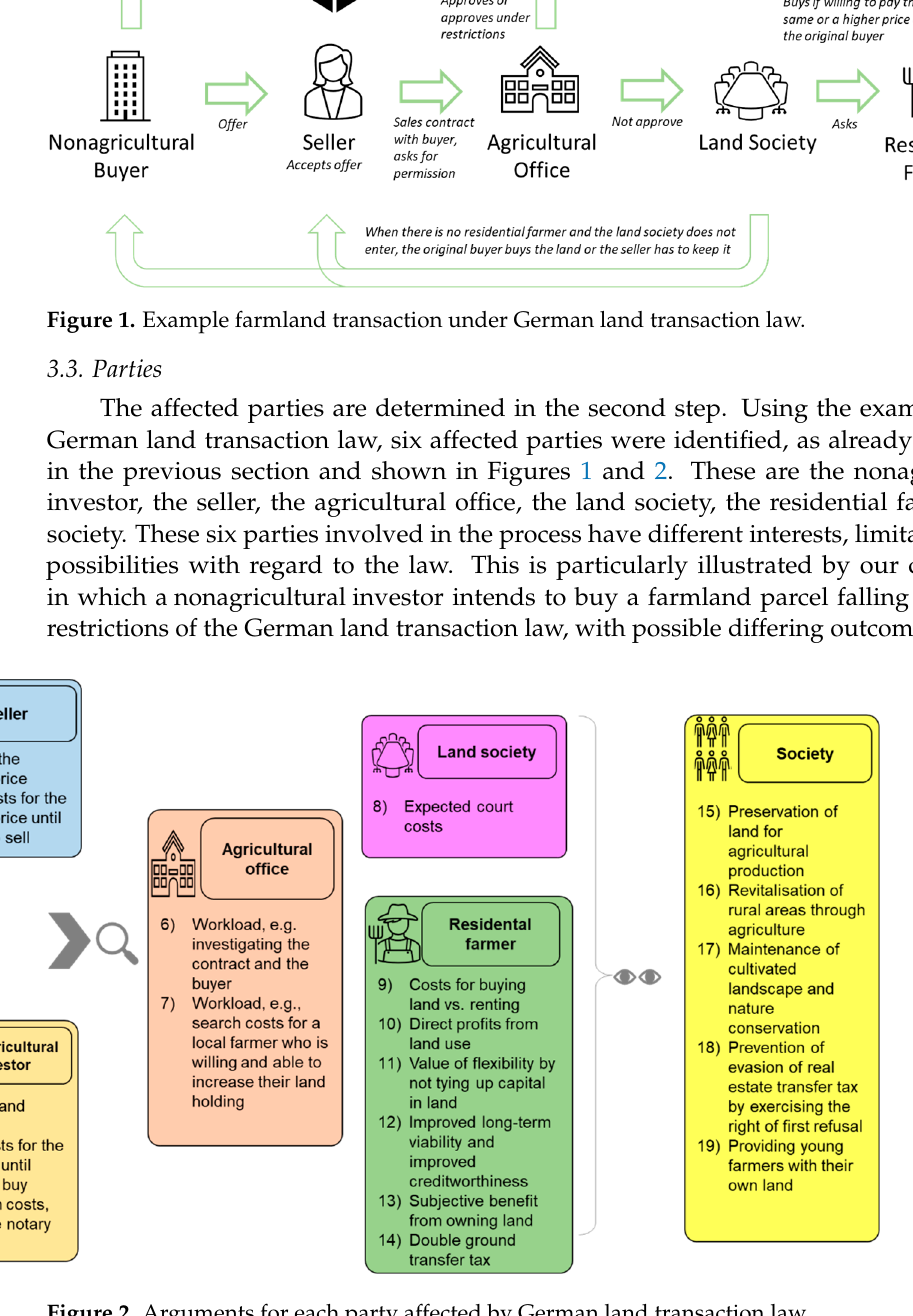
Figure 2. Arguments for each party affected by German land transaction